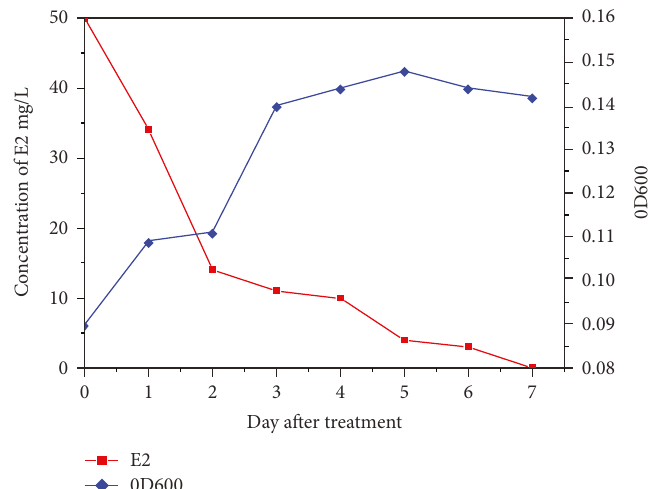
Figure 3: Growth curve and degradation curve of estradiol as the sole carbon source Rhodococcus sp. DSSKP-R-001: 50mg/L E2, day 3, high- performance liquid phase.